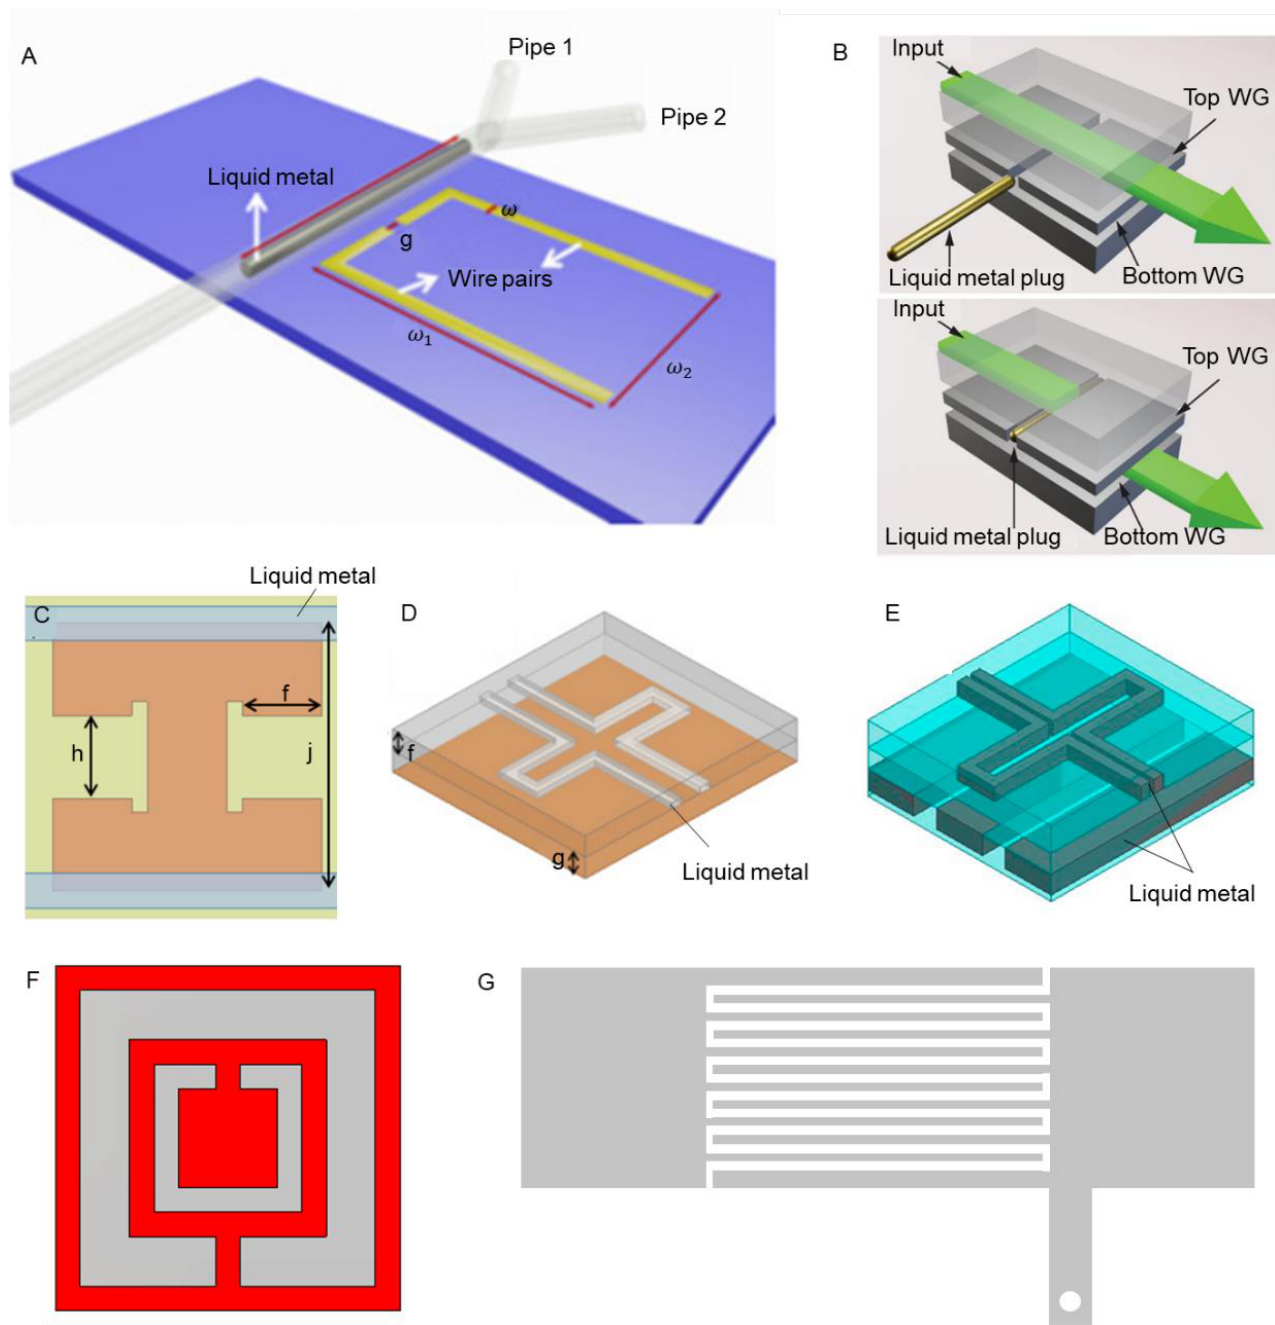
Figure 1. Illustration of liquid-metal metamaterials. ( A ) switchable EIT metamaterial [36]; Reproduced with permission from Optics Express; published by OSA Publishing, 2019. ( B ) electrically reconfigurable terahertz signal processing device with a liquid-metal plug [37]; Reproduced with permission from Nature Communications; published by Springer Nature, 2018. ( C ) frequency-switchable metamaterial absorber [38]; Reproduced with permission from Sensors; published by MDPI, 2015. ( D , E ) flexible metamaterial absorbers based on PDMS and liquid metal [39,40]; Reproduced with permission from Optics Express; published by OSA Publishing,2015. Reproduced with permission from Sensors; published by MDPI, 2016, respectively. ( E , F ) SRR structure; ( G ) transmission line configurations. (Reproduced with permission.)